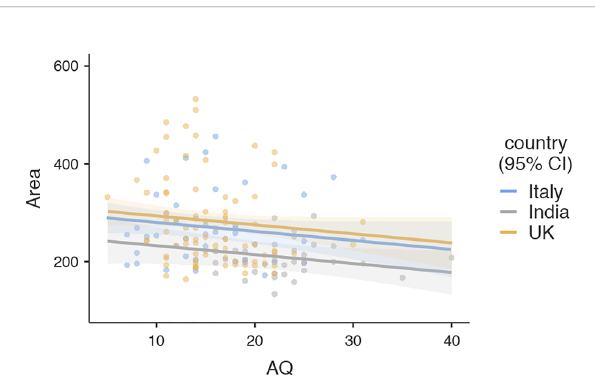
FIGURE 2 | Scattergram illustrating the relationship between closeness rating and articulation space. Regression line and con fi dence intervals correspond to results of the hierarchical linear model presented in Table 2 (Area: Articulation Space, CR: Closeness Rating).